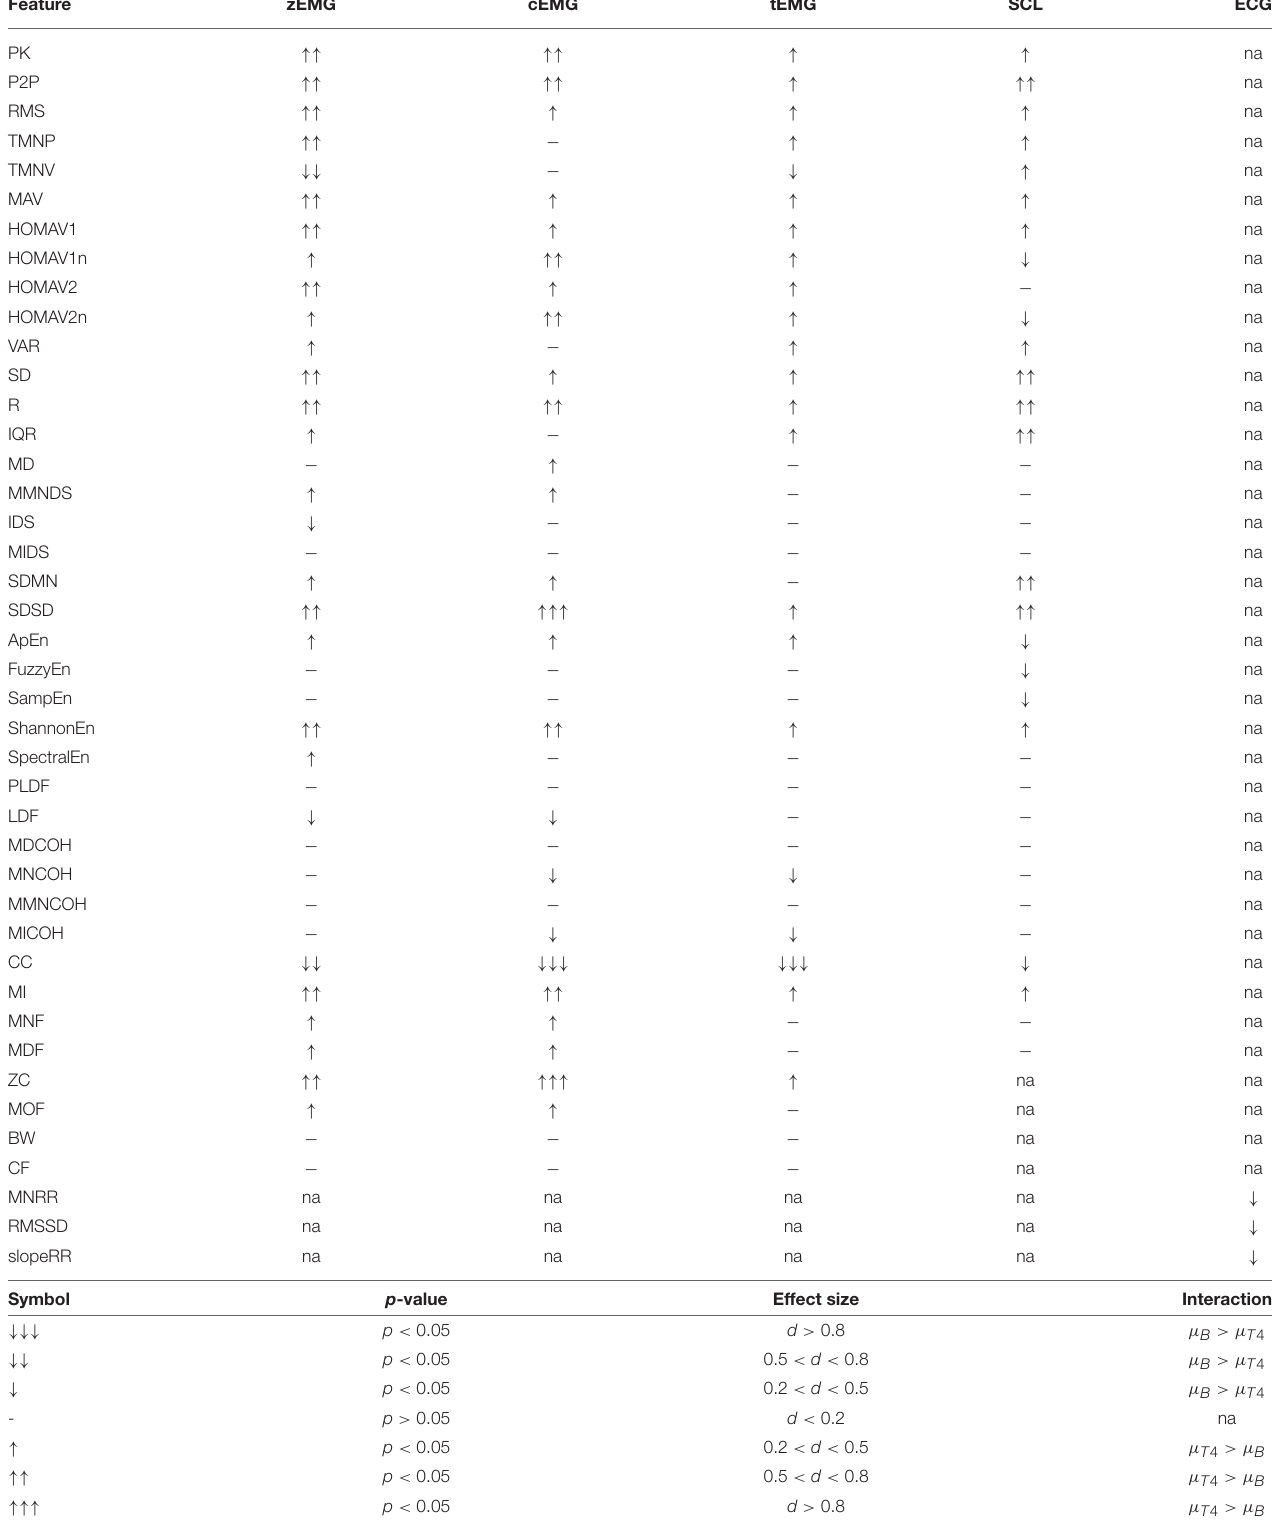
TABLE 4 | Relationships between heat-pain intensity and features derived from zEMG, cEMG, tEMG, SCL, and ECG.